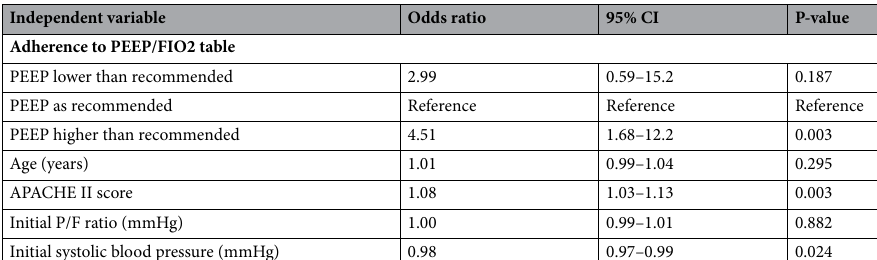
Table 4. Logistic regression for hospital mortality, by adherence to low PEEP/FIO2 table. APACHE Acute Physiology and Chronic Health Evaluation, FIO2 Inspired oxygen fraction, PEEP Positive end-expiratory pressure, P/F ratio Ratio of arterial oxygen partial pressure to inspired oxygen